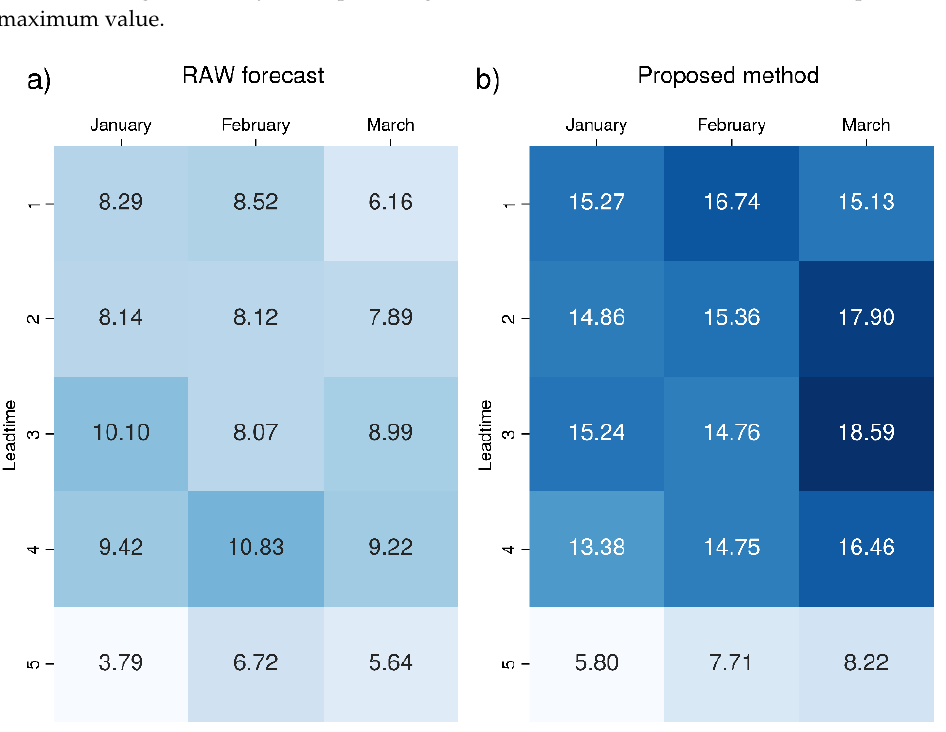
Figure 13. Mean percentage of ensemble members correctly predicting 2 m mean temperature over the 99th percentile value for seasonal forecast GCFS2.1 (DWD): ( a ) raw data and ( b ) data corrected with the proposed bias correction method. The colour scale ranges from white (0%) to dark blue, increasing in intensity as the percentage increases. The most intense colour corresponds to the maximum value.